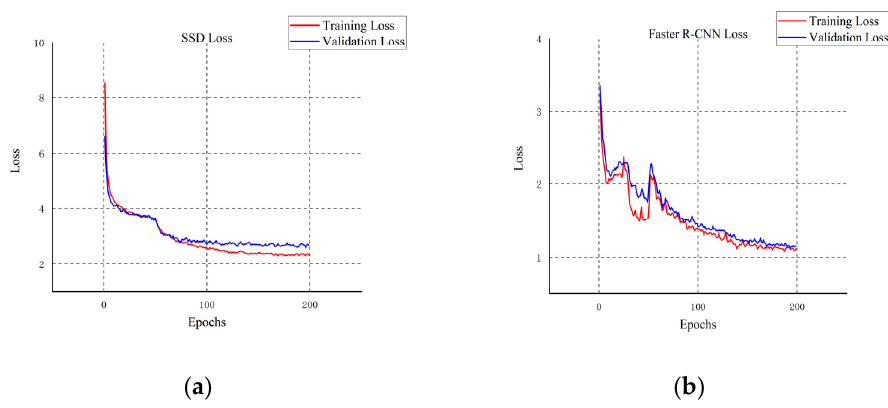
Figure 9. ( a )The loss changes of the SSD model; ( b )The loss changes of the Faster R-CNN model. Figure 9. ( a ) The loss changes of the SSD model; ( b )The loss changes of the Faster R-CNN